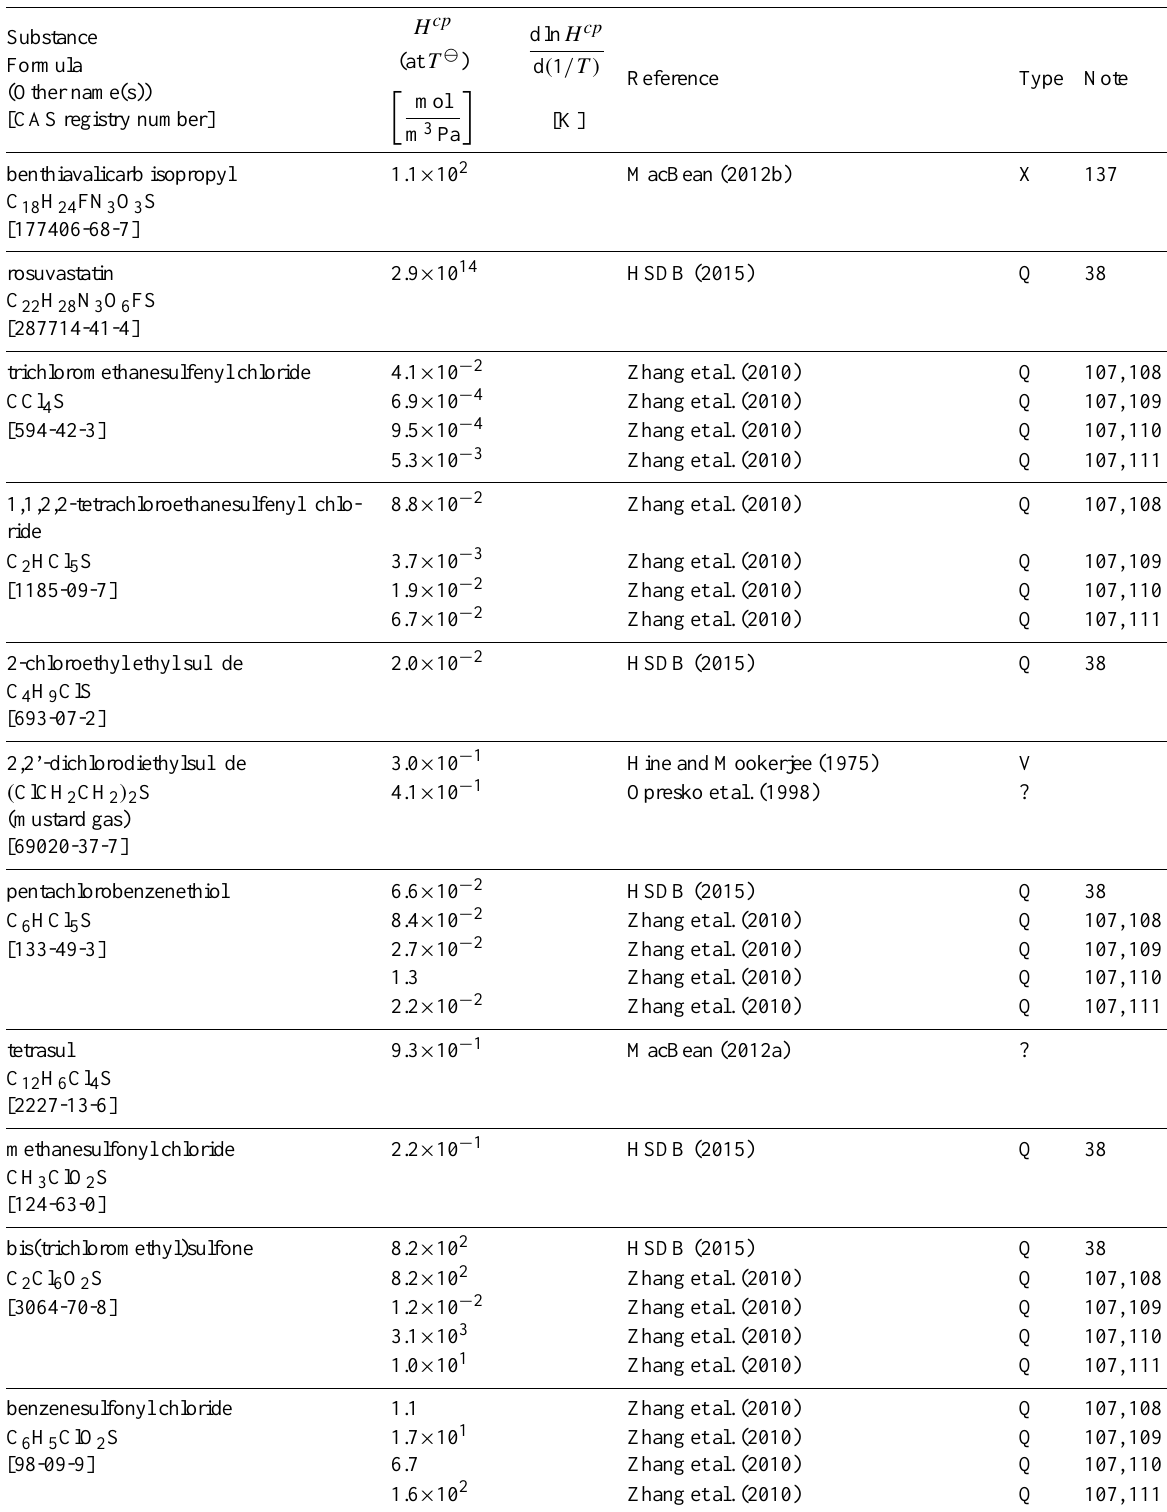
Table 6: Henry’s law constants for water as solvent